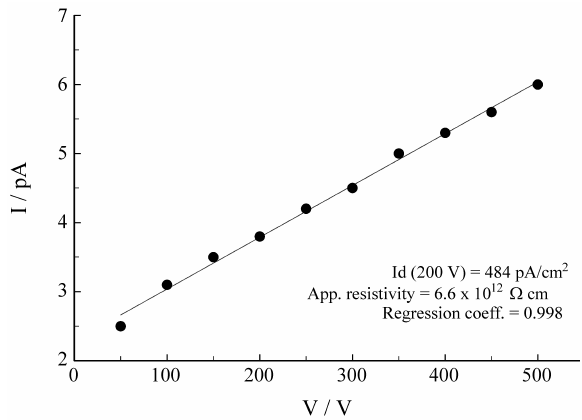
Figure 3. I-V room temperature plots for the detector assembled with the platelet of Fig. 2a by Pd thermal deposition and aquadag